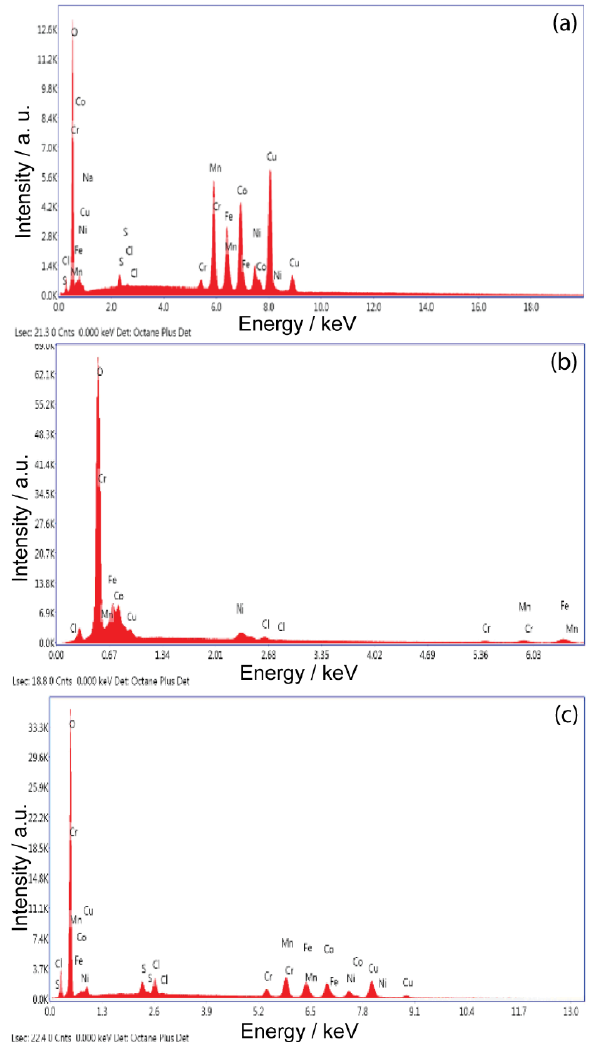
Figure 1. EDS spectra for the CoCrFeMnNi alloy deposited at −2.5 V for different periods of time: ( a ) 30 min; ( b ) 60 min; ( c ) 90 min.